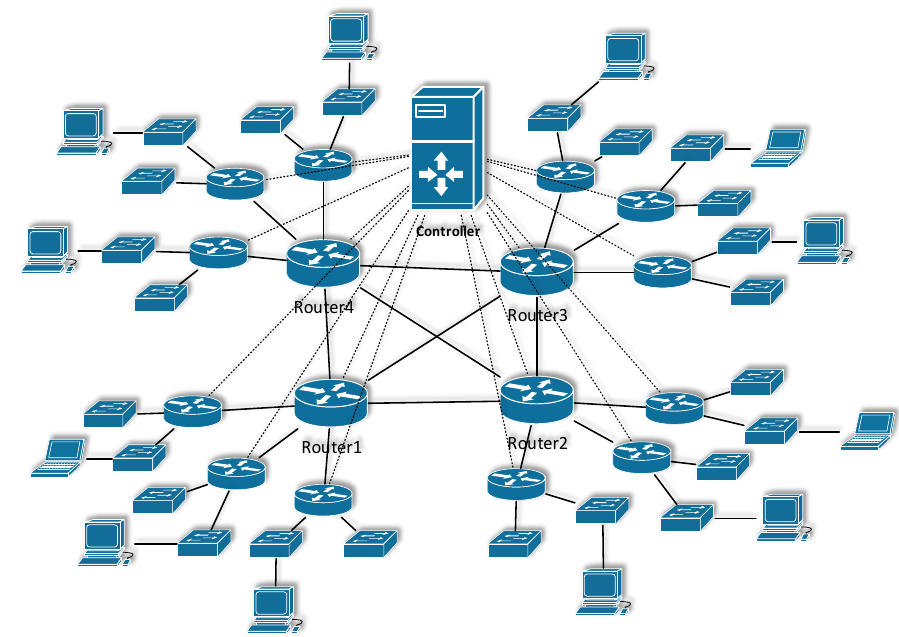
Figure 19. The IBN (Intent-based networking) network topology with controller.